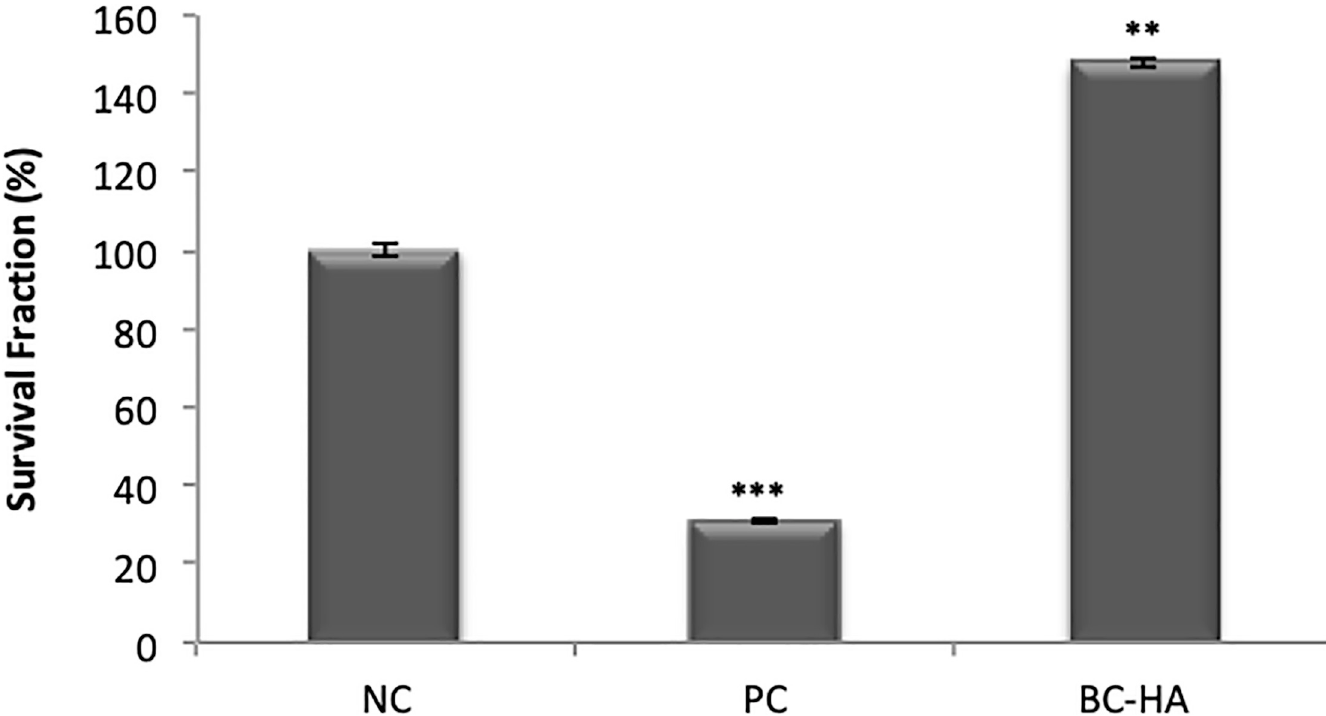
Fig 4. Cytotoxicity assessed by clonogenic survival assay. Columns indicate mean Survival Fraction (%). NC represents 100% survival fraction. Bars indicate standard error. The ��� symbol indicates statistically significant difference compared to NC (p < 0.0001). Dunnett’s test.